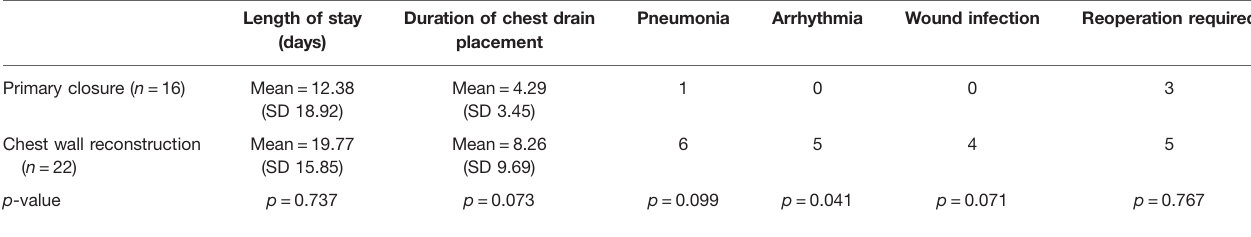
TABLE 3 | Post-operative complications/outcomes — primary closure vs. chest wall reconstruction (both MatrixRIB ™ implantation and prosthetic patch/autologous fl ap